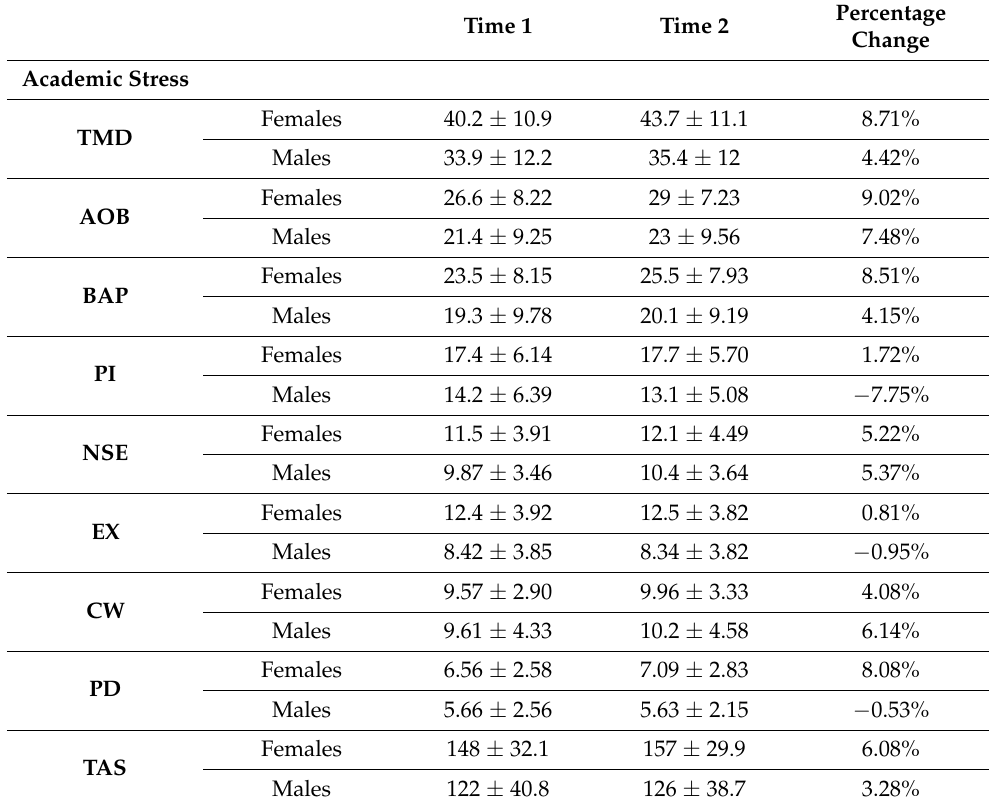
Table 4. Differences in academic stress in Time 1 (before lockdown declaration) and Time 2 (after lockdown) based on Sex. Time 1 Time 2